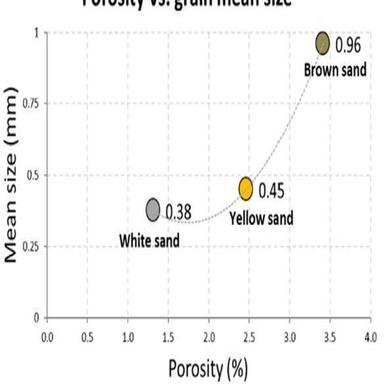
Porosity vs. grain mean size.